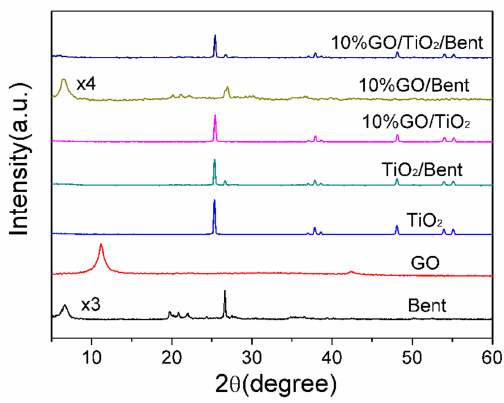
Figure 4. XRD patterns of Bent, GO, TiO 2 , TiO 2 / Bent, 10% GO / TiO 2 , 10% GO / Bent and 10% GO / TiO 2 / Bent.